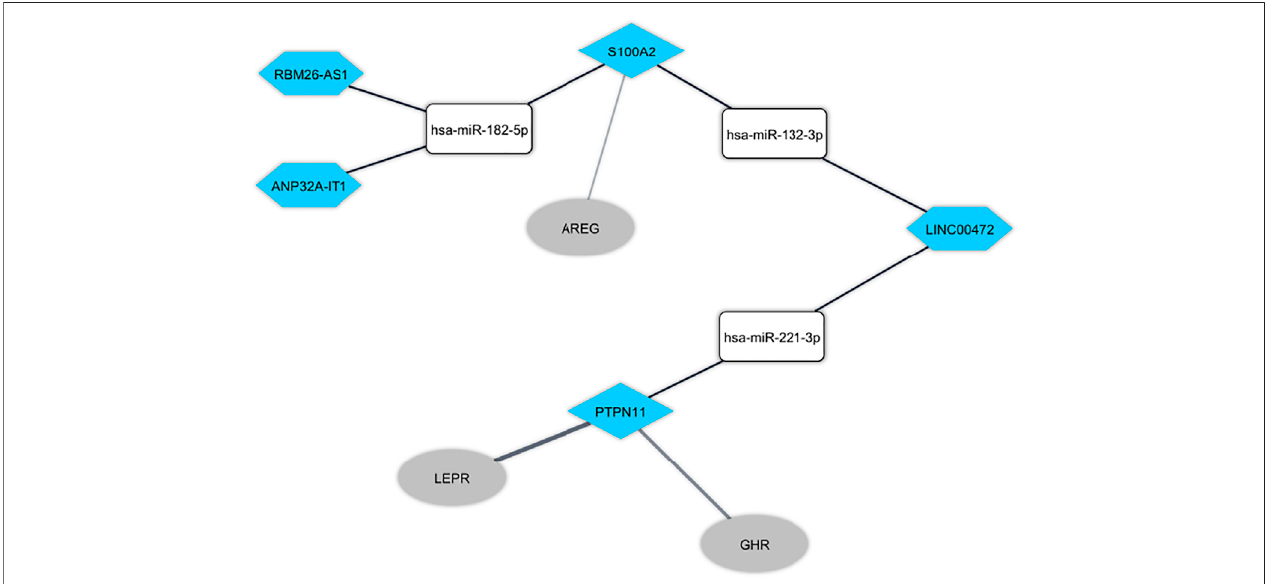
FIGURE 5 | The immune-related long non-coding RNA (lncRNA)-associated competing endogenous RNA network in peripheral blood in autism spectrum disorder. The hexagon nodes and the round rectangle nodes represent the lncRNA and miRNA, respectively. The diamond nodes represent miRNAs targeted mRNAs. The ellipse nodes represent downstream connected mRNAs. The blue nodes represent the